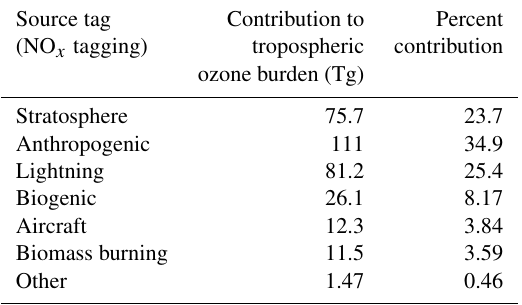
Table 1. Contribution to annual average tropospheric ozone burden from tagged NO x sources and transport from the